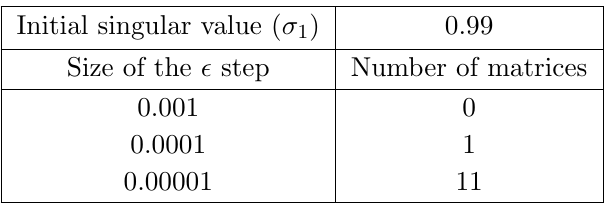
Table 2 . A number of matrices that can reach the value of the (cid:12)rst singular value ( (cid:27) 1 ) equal to 1 (cid:6) 3 (cid:1) 10 (cid:0) 5 starting from 0.99. When the precision of (cid:15) increases, it is more probably to (cid:12)nd non-zero